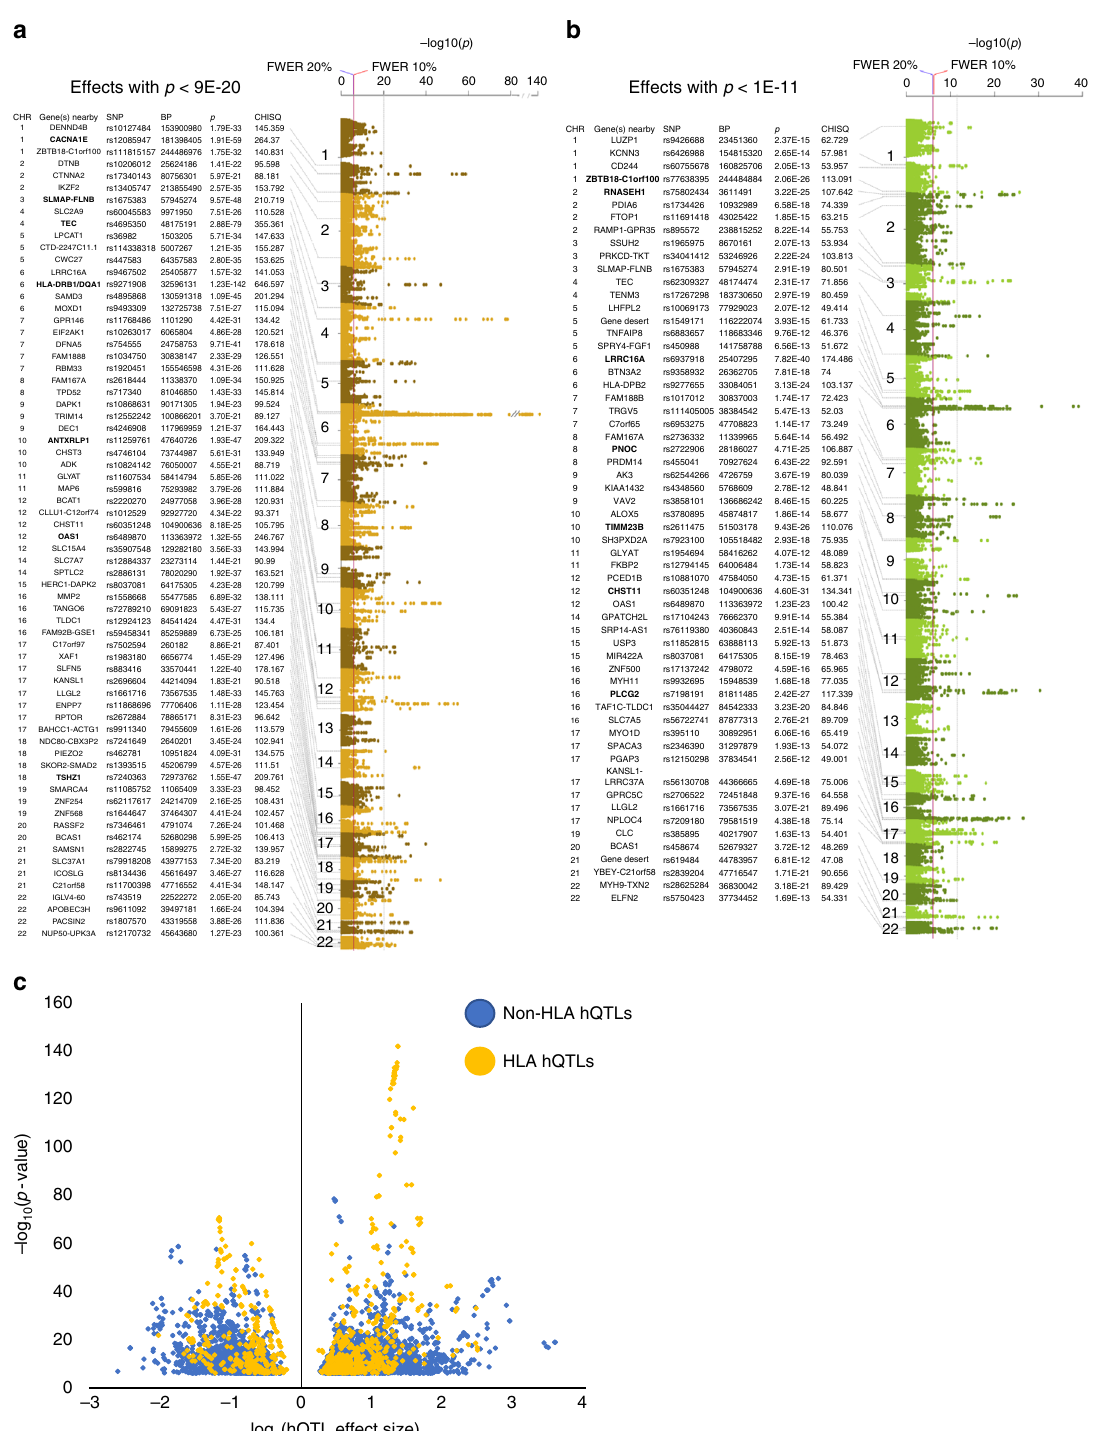
p ) from the CHT; chromosome position 10 (